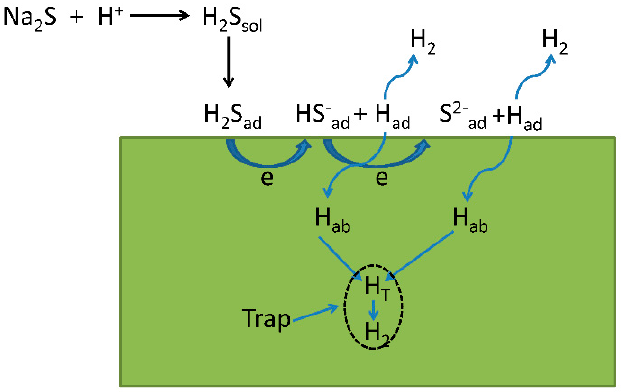
Figure 11. Adsorption mechanism of sulfide on metal surface.